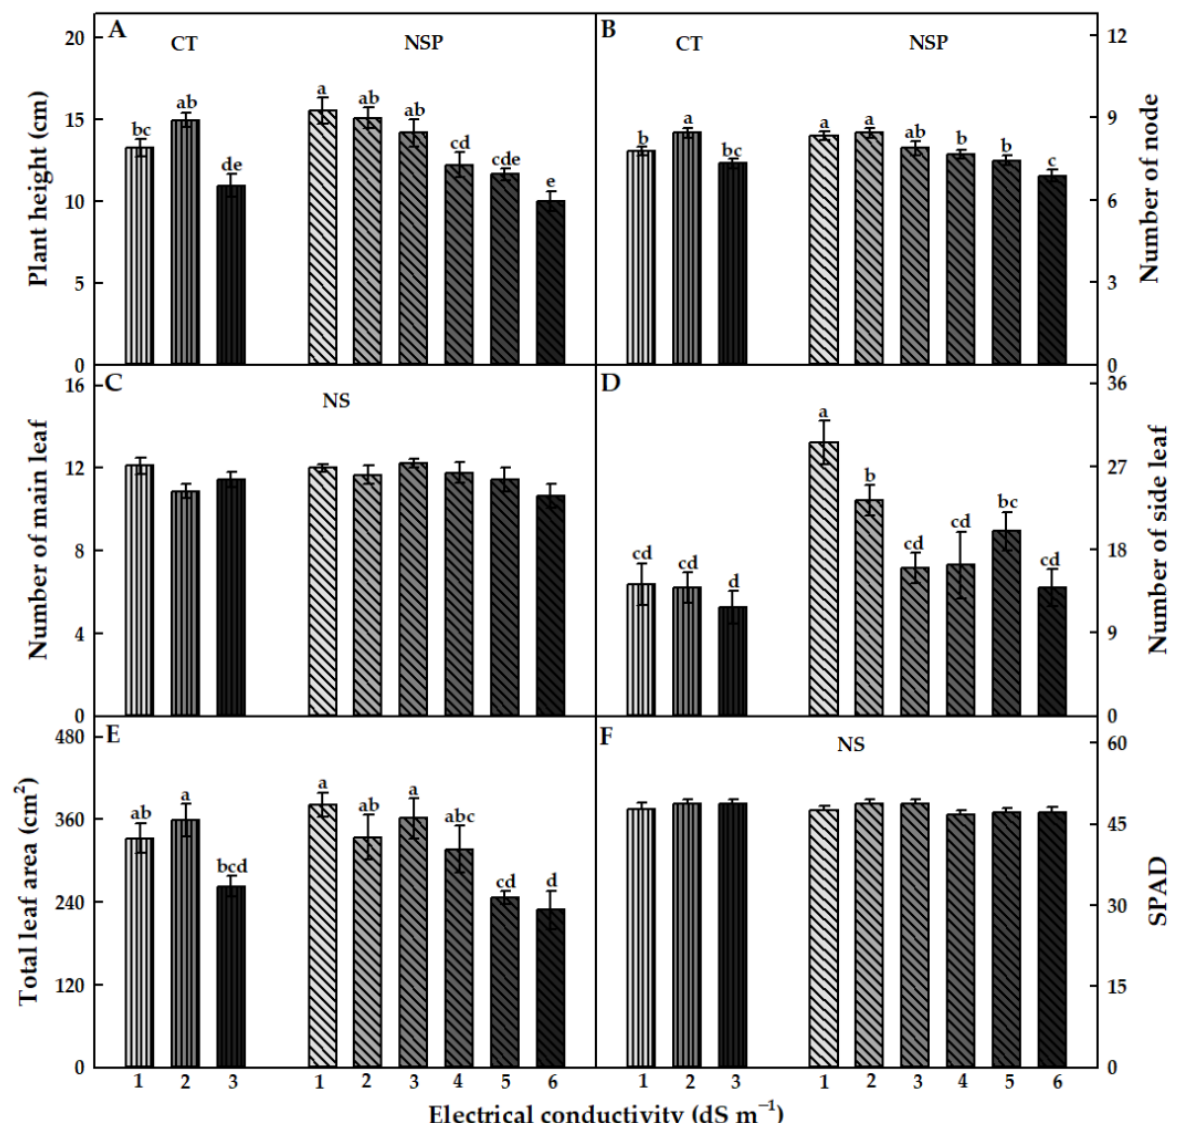
Figure 3. Plant height ( A ), number of node ( B ), number of main and side leaves ( C , D ), total leaf area ( E ), and SPAD ( F ) of red perilla plants grown under various EC levels of greenhouse nutrient solution (CT) and newly-developed nutrient solution for red perilla (NSP) after 7 weeks of transplanting. Different letters indicate significant difference at p < 0.05 ( n = 9). NS means no statistically significant difference.